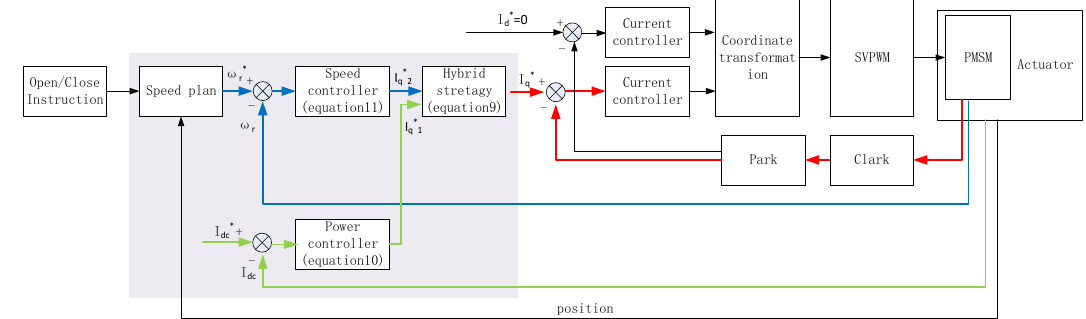
Figure 6. Block diagram of the hybrid control strategy.